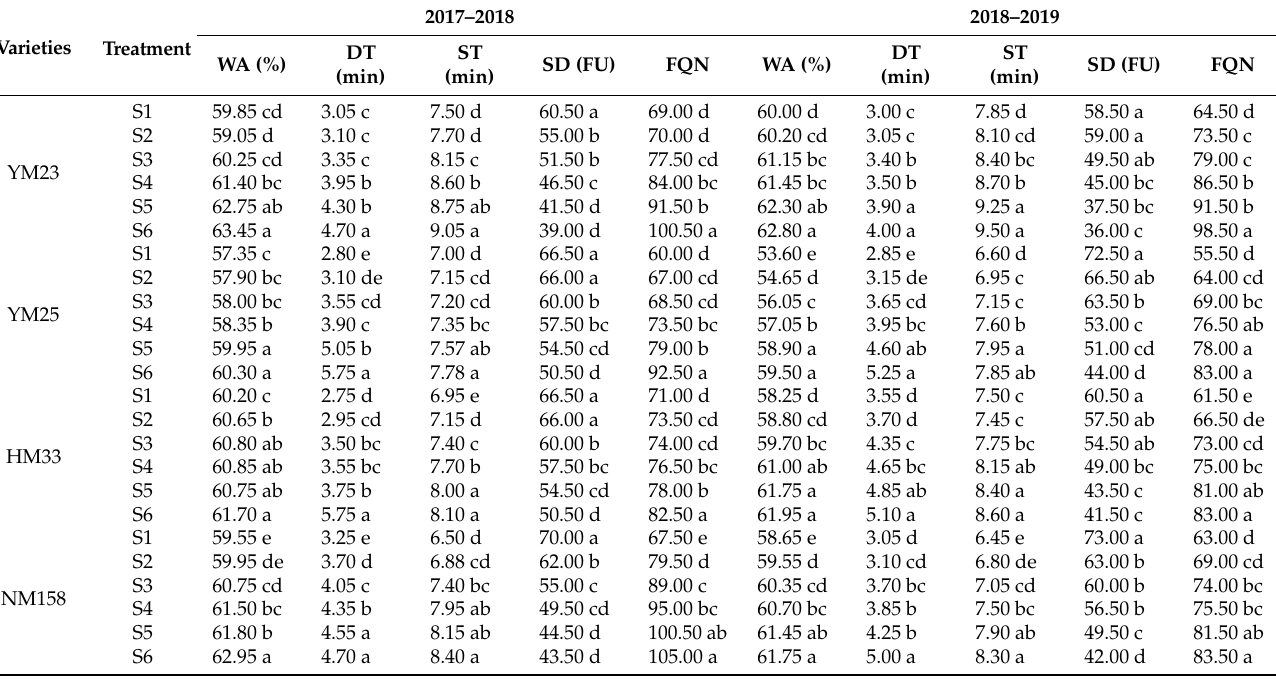
Table 3. Effects of temperature and radiation on wheat dough properties.